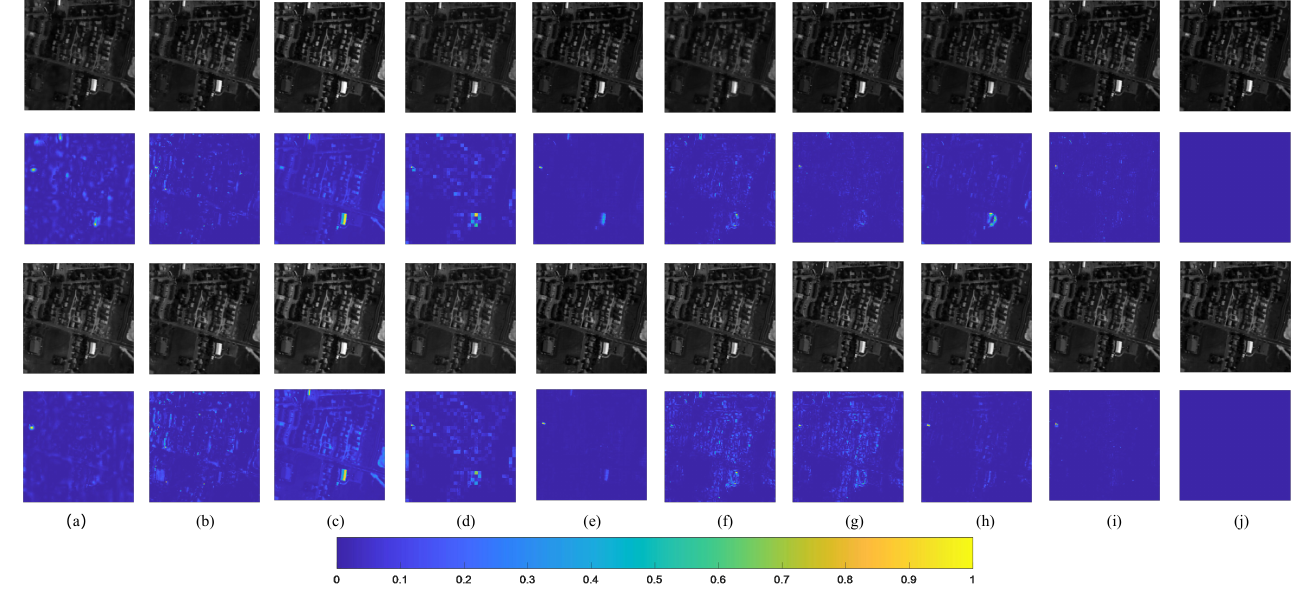
Figure 4. Reconstructed HR-HSI and corresponding error images for Ubran. First and second rows: reconstructed HSI and its corresponding error image at the 25th band. Third and fourth rows: reconstructed HSI and its corresponding error image at the 40th band. ( a ) GSA; ( b ) CNMF; ( c ) CSU; ( d ) NSSR; ( e ) LRSR; ( f ) LTTR; ( g ) FuVar; ( h ) LRTD; ( i ) HTSR; ( j ) Ground truth.